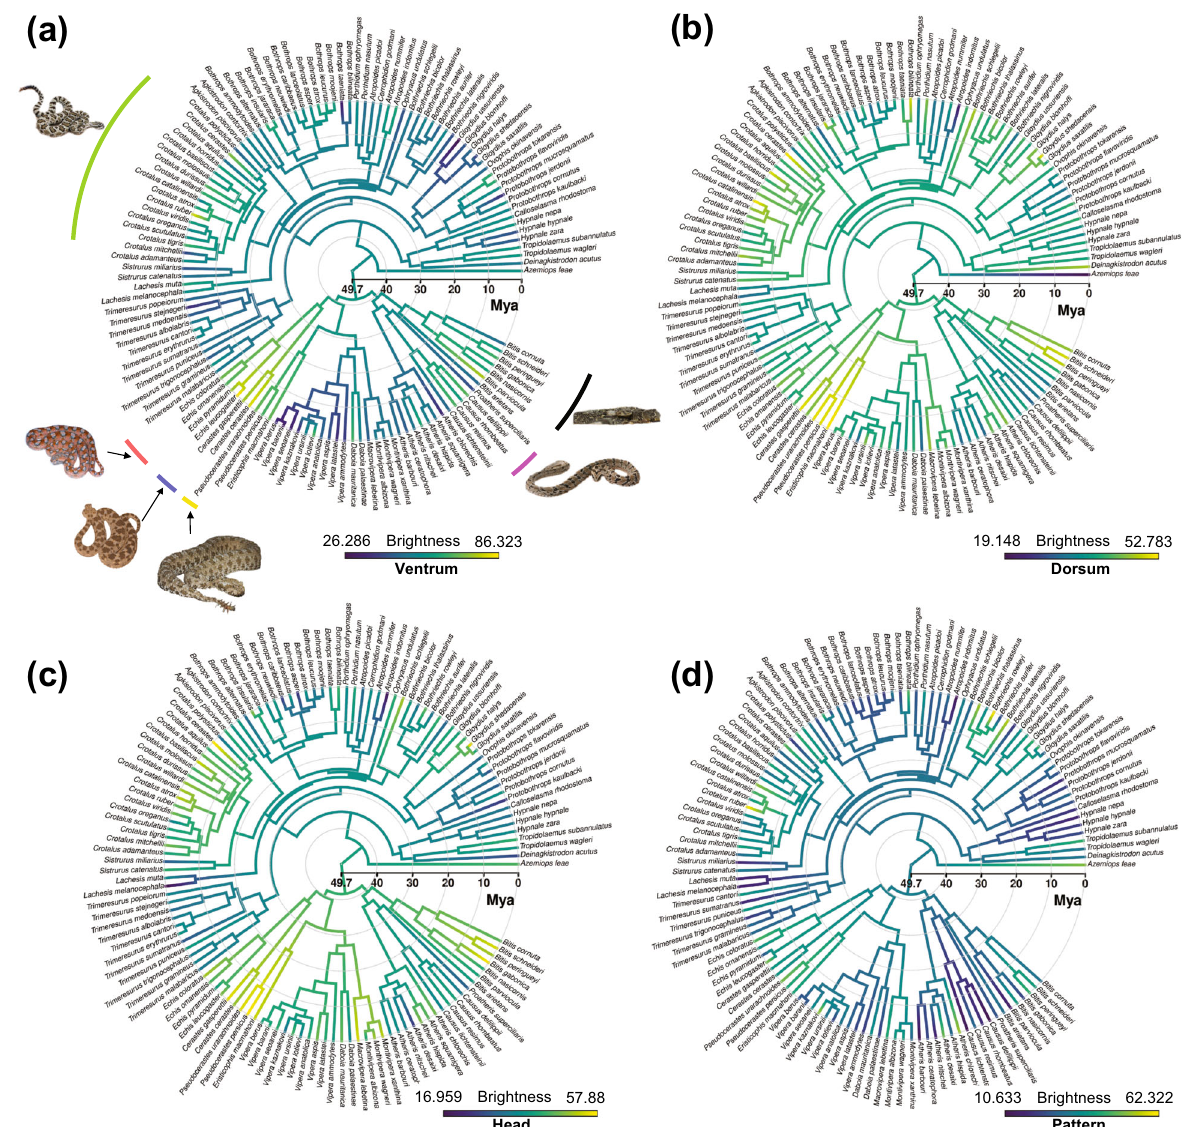
Fig. 3 Viperidae ancestral brightness estimation across different body regions. Viperidae ancestral state estimation of ( a ) ventral brightness, indicating convergent evolution of particularly dark and bright ventral integuments; ( b ) dorsal brightness showing an overall convergent brightness increase across different genera/species; ( c ) head brightness showing a similar trend to the dorsal brightness; and ( d ) pattern brightness indicating a global decrease of brightness since ~20 Mya. Note that six species ( Atheris squamigera , Trimeresurus albolabris , T. erythrurus , T. medoensis , T. popeiorum , T. stejnegeri ) do not show clear pattern shapes, therefore we dropped them from pattern analysis. Branches with blues (darker tonality) indicate dark colors, greens show the mid-brightness ancestral state and yellows (brighter tonality) specify bright colors. Credits: Crotalus oreganus (© Will Flaxington, CC BY-NC 3.0), Echis coloratus (© Matthieu Berroneau — with permission), Cerastes cerastes (© MinoZig, CC BY-NC 3.0.), Pseudocerastes urarachnoides (© Omid Mozaffari, CC- public domain), Causus rhombeatus (© Paul Venter, CC BY-NC 3.0.), Bitis arietans (© Jonathan brightness of the focal taxa (Table S23); speci fi cally C1 (i.e., the maximum distance between two lineages that has been brought together by subsequent evolution) = 0.54 ( p = 0.00) coupled with C5 (i.e., the number of convergent focal taxa that reside in a dis- tinct region of the polymorphospace) = 15 ( p = 0.00) show that the focal taxa signi fi cantly cluster together in a separate region of the polymorphospace driven by ventral brightness (Table S23, Fig. S14). As another line of evidence, the 95% C.I. phenogram, which projects the phylogeny in a space de fi ned by the ventral brightness over time (Fig. S15B), shows that ventral brightness of the focal taxa shifted to bright brightness levels independently over time, corroborating our fi ndings.